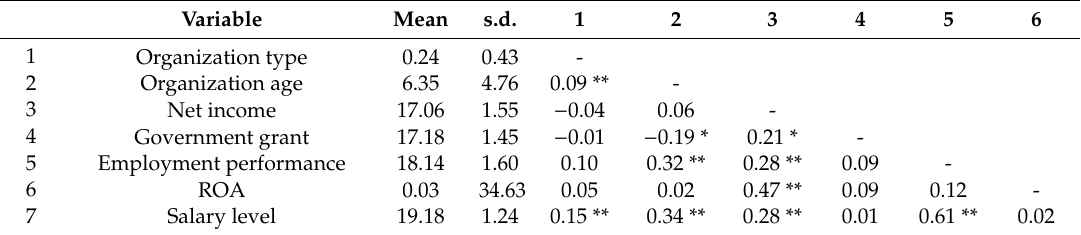
Table 2. Means, standard deviations, and correlations among study